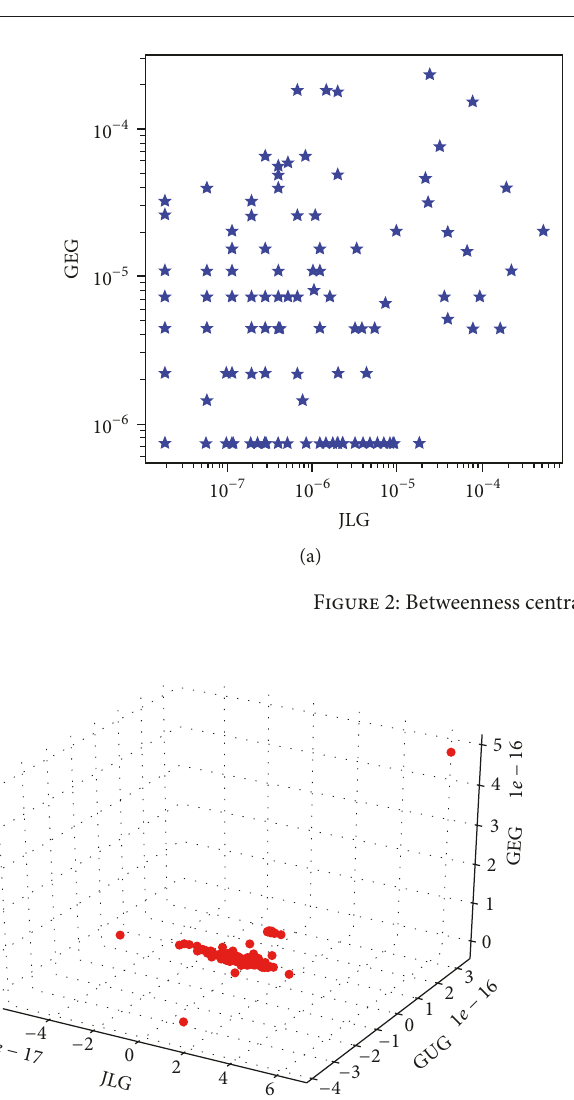
Figure 3: Eigenvector centrality of the multiplex